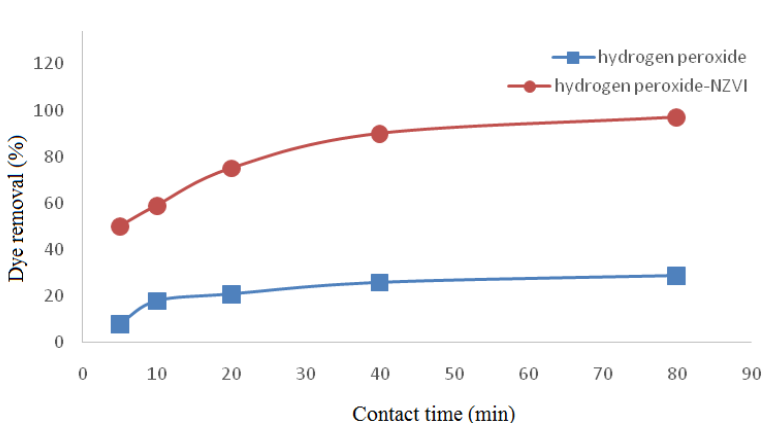
Fig 5. Effect of contact time on efficiency process. (Saturation: 75 mg/L, pH=4, concentration of nanoparticles: 2 g/L, hydrogen peroxide concentrations: 200 Mmol). intense mixing. This phase takes about 30